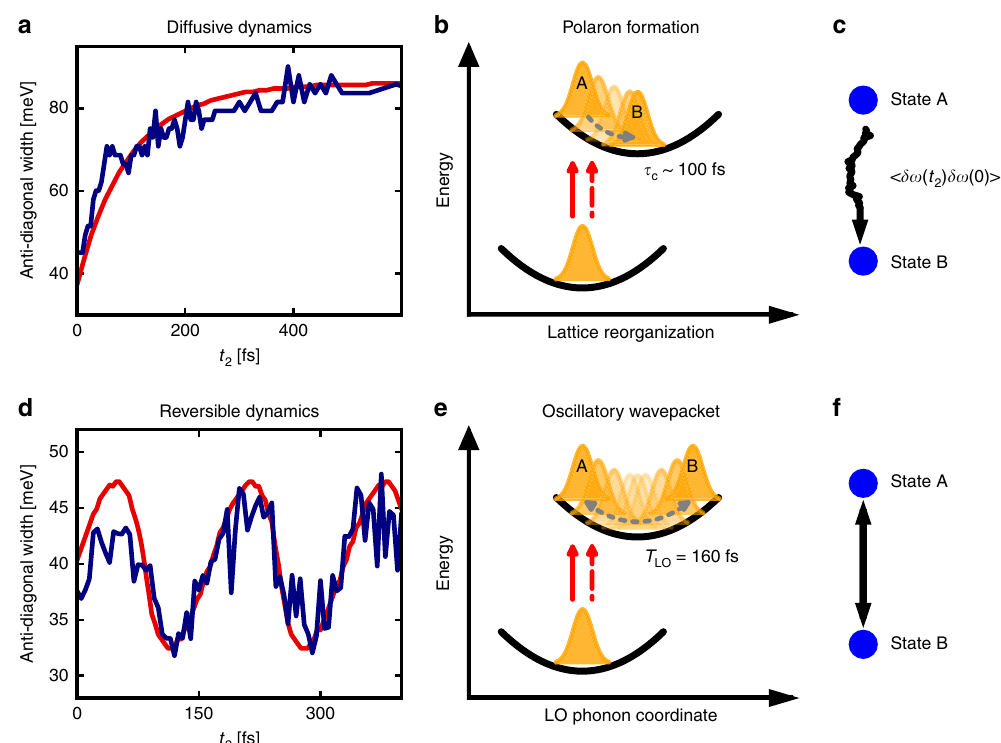
Fig. 5 Modeling of the CsPbI 3 nanocrystals ʼ lineshape evolution by diffusive dynamics. a The anti-diagonal linewidth of the CsPbI 3 nanocrystals (dark-blue curve) is well modeled by a Kubo lineshape (red curve), corresponding to dissipative dynamics typical of molecular solvation or solid-state polaron formation. b , c Schematic illustrations of the dynamics in ( a ). Collective structural dynamics following photoexcitation (red arrows), whether solvent or lattice, result in excited-state dynamics (orange wavepackets) that evolve from an initial state A toward equilibrium B. d The anti-diagonal linewidth of the CdSe nanocrystals (dark-blue curve) is well modeled by the Huang – Rhys regime (red curve), corresponding to electron – phonon coupling with quantum modes undergoing reversible wavepacket dynamics with period T LO . e , f Schematic illustrations of the dynamics in ( d ), with a single quantum coordinate. This regime supports wavepacket dynamics, where the electron wavepacket (in orange) oscillates between states A and